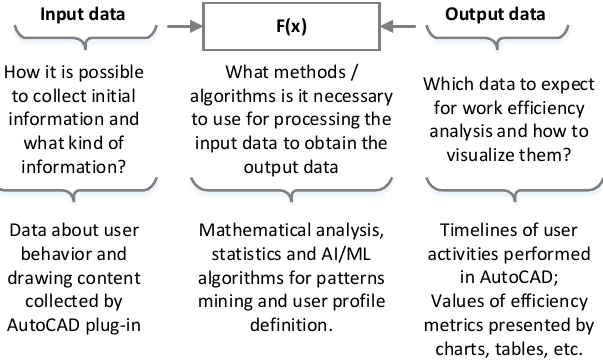
Fig. 5 . Depiction of the result s of this paper regarding original research question